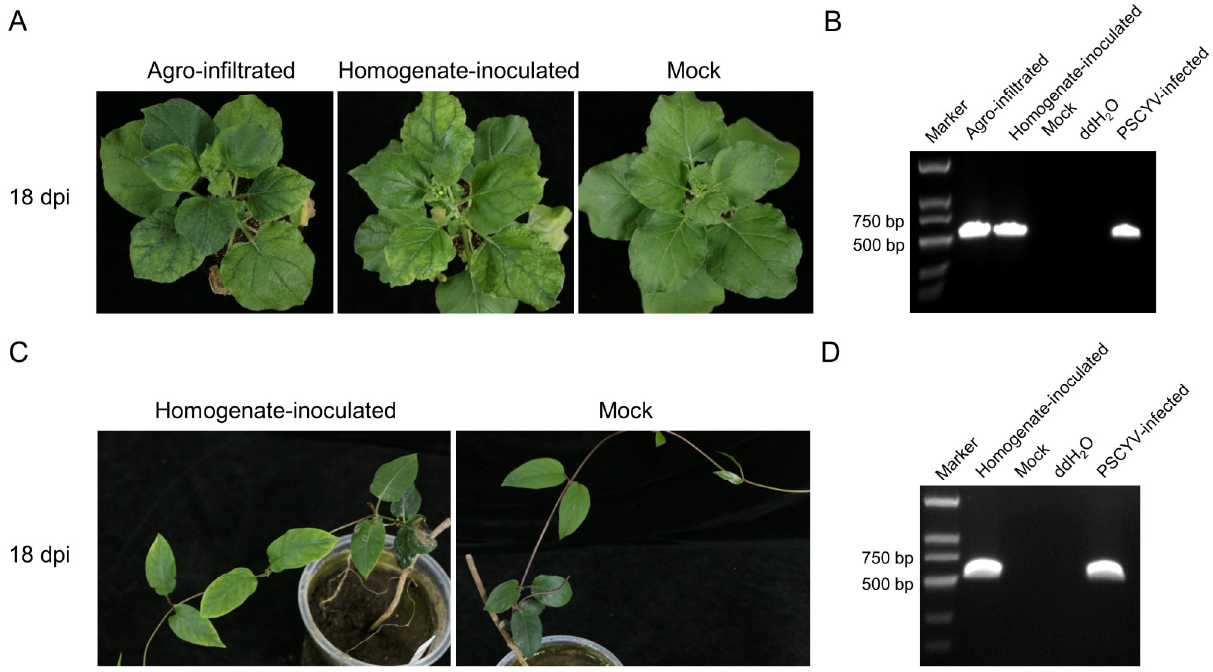
Figure 8. Agroinfiltration inoculation of the infectious clone and mechanical inoculation of PSCYV. ( A ) Symptoms of N. benthamiana plants inoculated with the infectious clone of PSCYV ( left ) and the homogenate of PSCYV-infected Paederia scandens ( middle ) compared with the mock inoculated plant ( right ). N. benthamiana plants were infiltrated with A. tumefaciens cultures carrying pCB301- PSCYV, or mechanically inoculated with the homogenate from the field-collected PSCYV-infected Paederia scandens plant. ( B ) RT-PCR detection of PSCYV in the plants as shown in ( A ). ( C ) Symptoms of mechanically inoculated Paederia scandens plants with the homogenate from agro-infiltrated N. benthamiana plant tissues. ( D ) RT-PCR detection of PSCYV in the plants shown in ( C ).